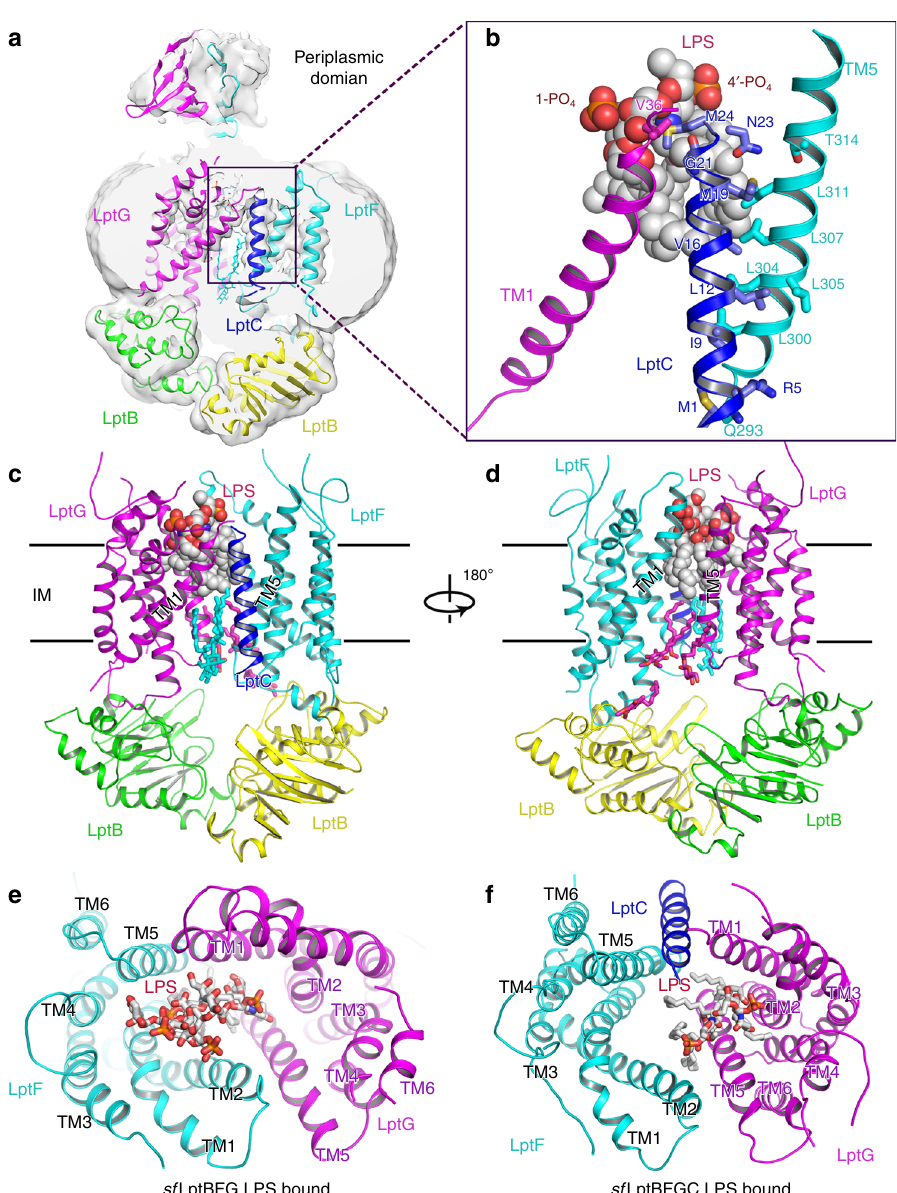
Fig. 3 Cryo-EM structure of LPS-bound sf LptB 2 FGC. a Cryo-EM map of LPS-bound sf LptB 2 FGC. The colour scheme is the same as in Fig. 1. LptC is coloured in blue. b A close view of LPS. Lipid A of LPS is visible in the complex and LptC transmembrane helix is at the lateral gate TM1G/TM5F. LPS is shown in spheres. c Cartoon representation of LPS-bound sf LptB 2 FGC. d Rotation of 180° along the y -axis relative to c . e Periplasmic view of LPS-bound sf LptB 2 FG, where LPS is closed to the LptF side. f Periplasmic view of LPS-bound sfLptB 2 FGC. LPS is closed to the LptG